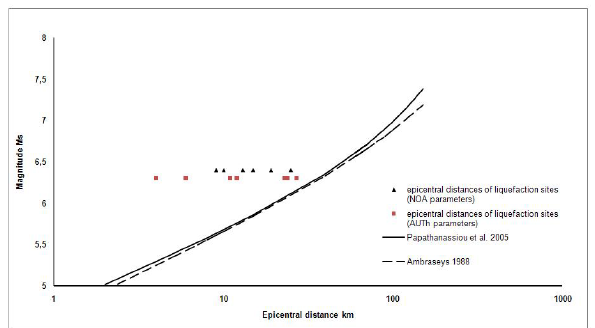
Figure 10. Distribution of the liquefied sites based on their epicen- tral distance and comparison to the upper bound curves proposed by Papathanassiou et al. [2005] and Ambraseys [1988] for the as- sessment of liquefaction